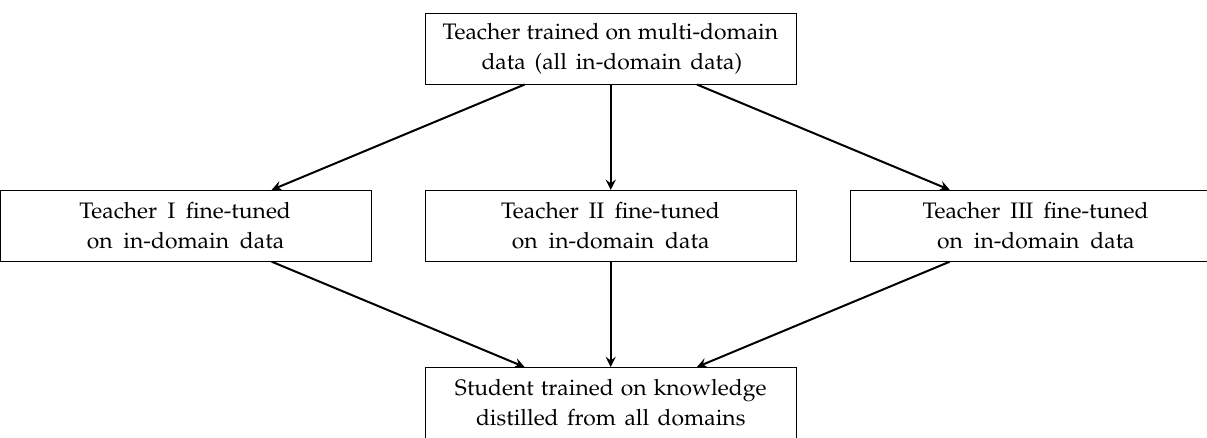
Figure 2. Flowchart of the process of distilling multiple domains as in Currey et al. [9] to create a general domain student